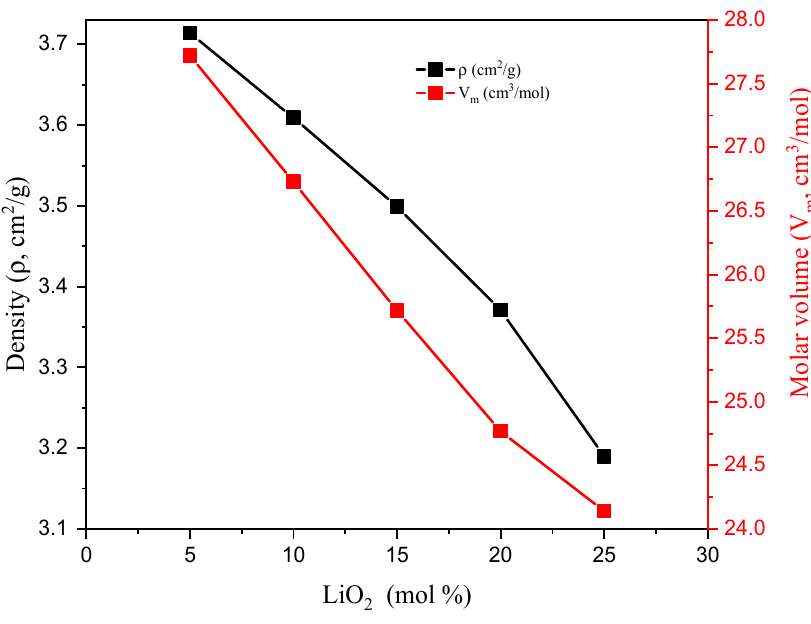
Figure 2. Variation in the density and molar volume versus the LiO 2 concentration. Table 2. Some mechanical properties for the glasses under study.